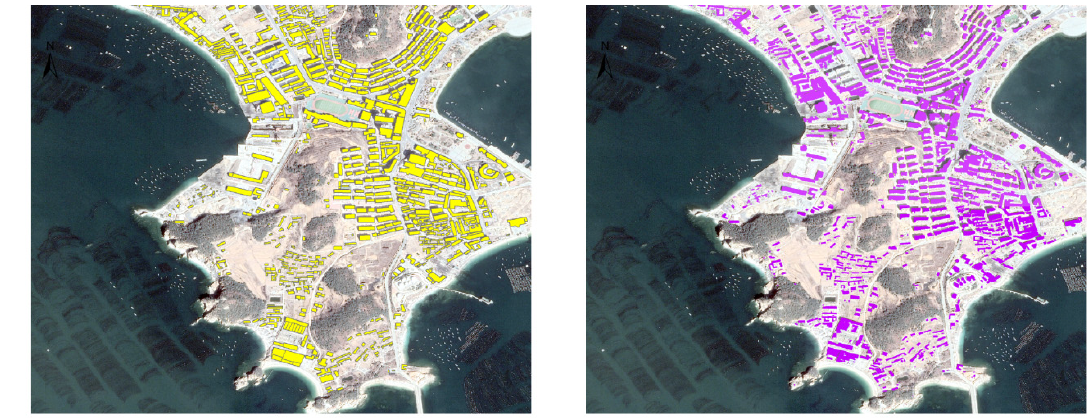
Figure 9. Ground truth mask ( a ) vs. predicted mask ( b ) of the buildings for the upper left part of the test area.